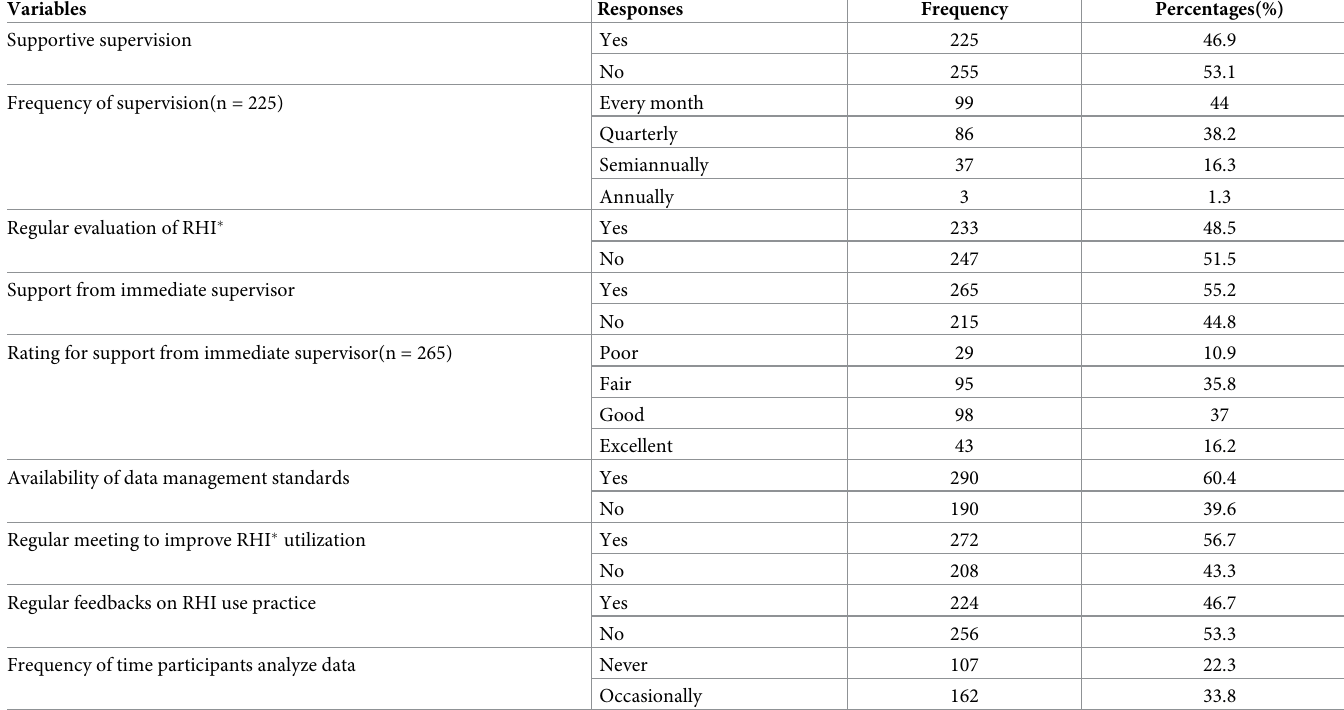
Table 3. Facility related characteristics at public health facilities of Hadiya zone, 2019, (n =